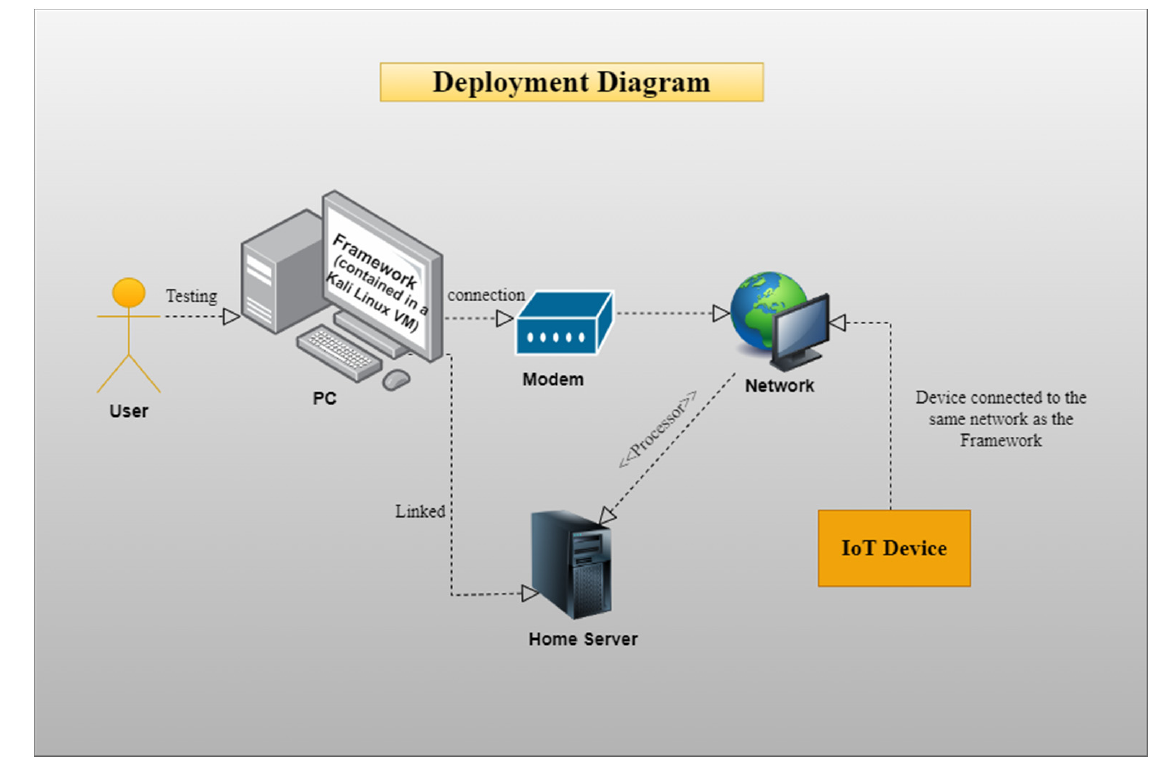
Figure 5. UML deployment diagram of the framework.